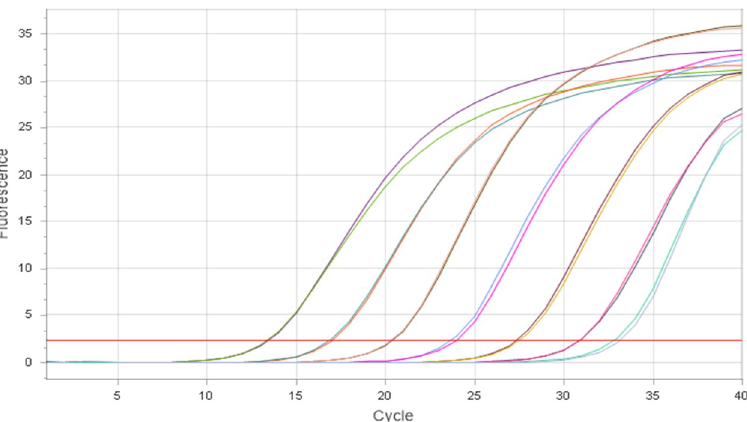
Fig 2. Amplification curves of 10-fold serial dilutions of A . pleuropneumoniae ATCC DNA (from 0.05 to 5,000 pg).